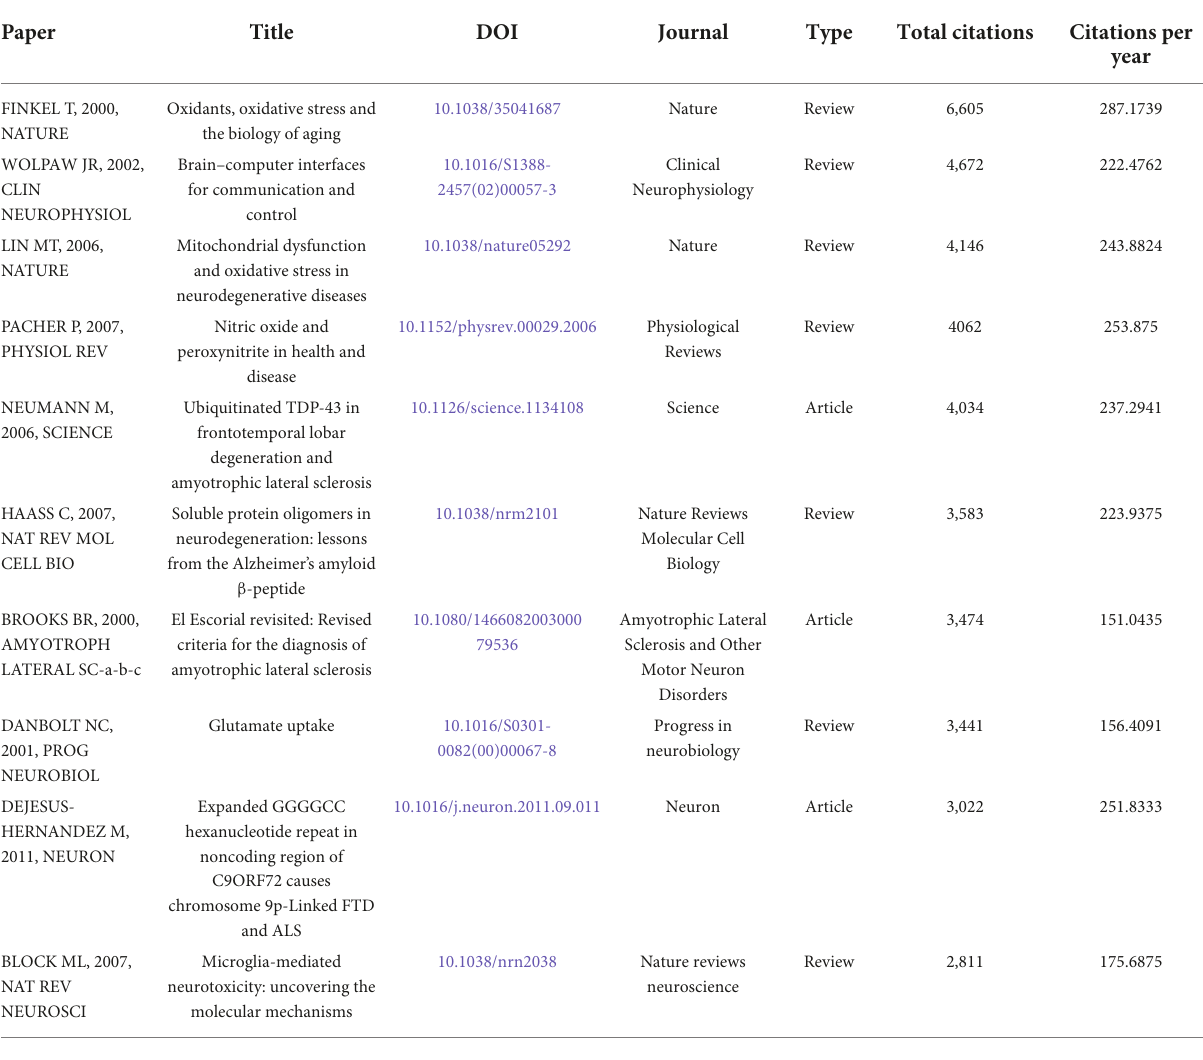
TABLE 4 Information of top ten most cited articles.